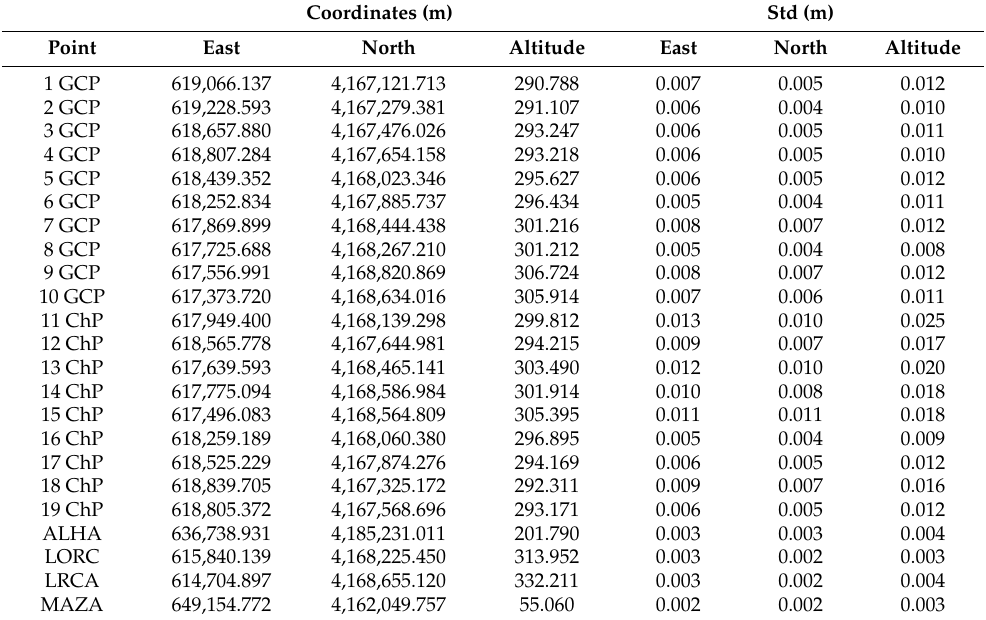
for the observation period used for the adjustment; Microsearch GeoLab software, reference system UTM 30N